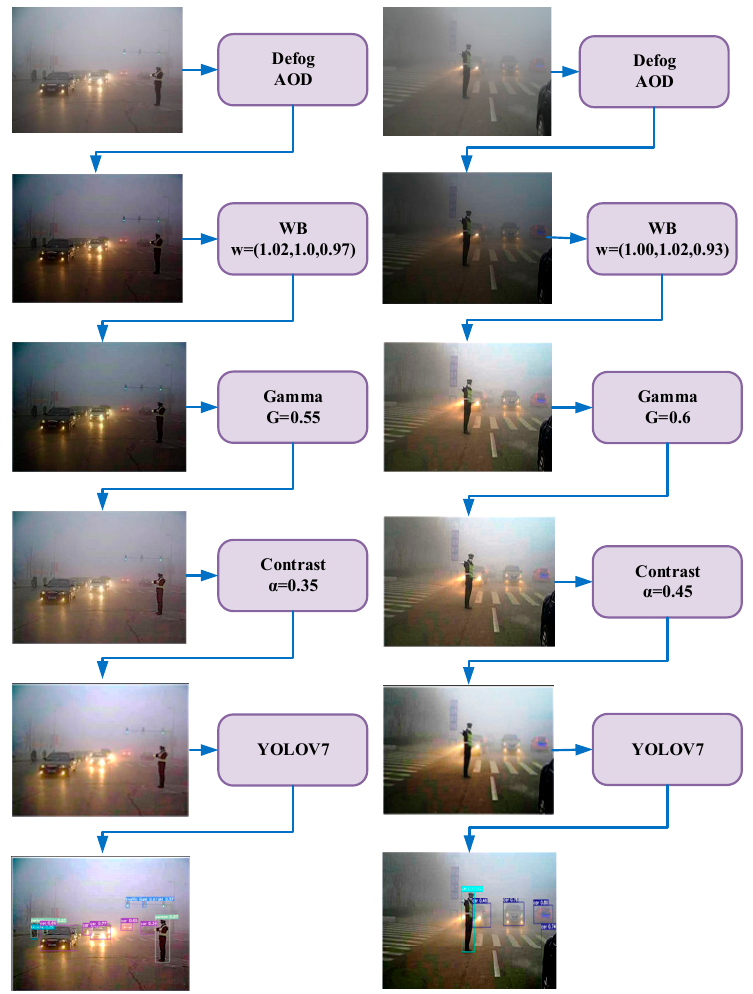
Figure 6. Examples of learned SAIP modules and their filtering outputs.